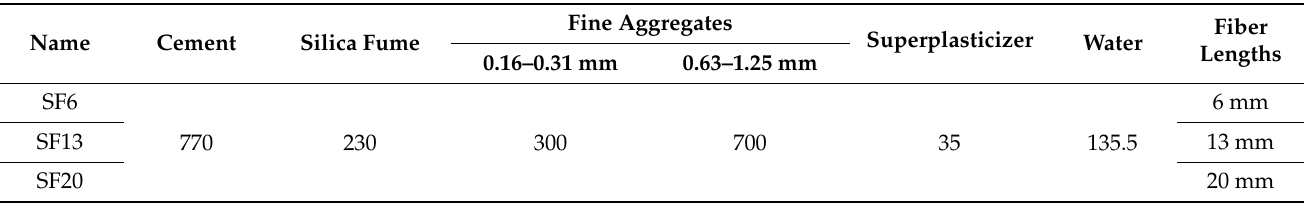
Table 3. Mix proportion of the UHPC mixture with a fiber volume fraction of 2.0% (kg/m 3 ).